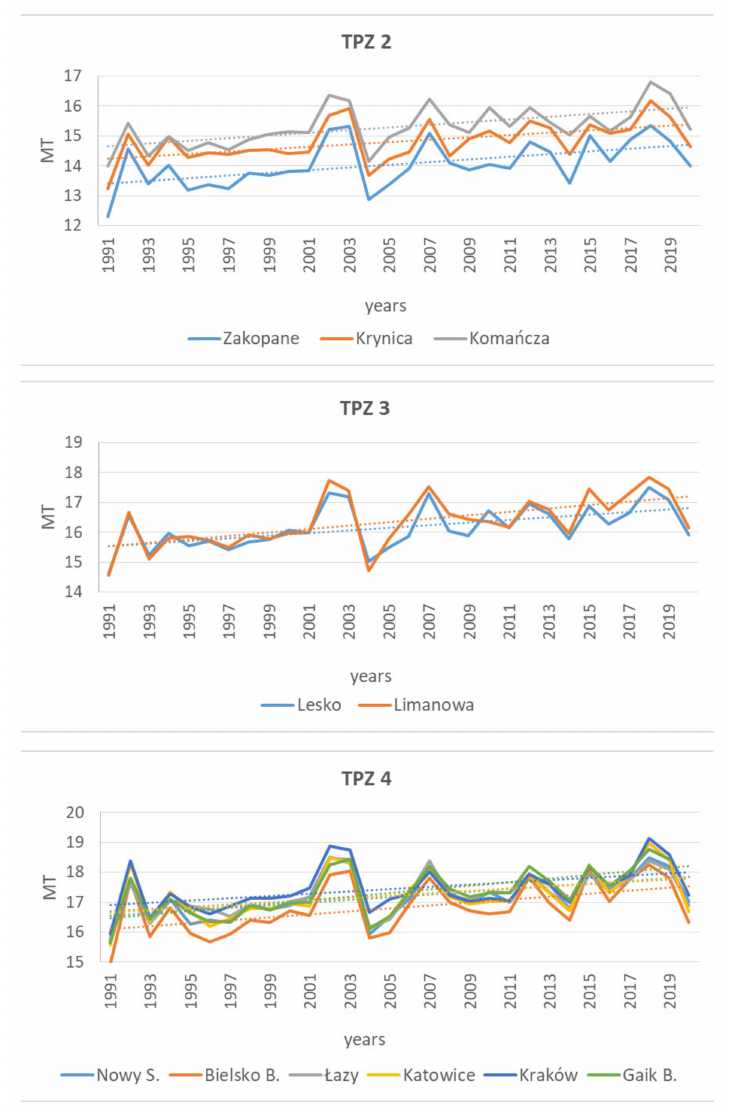
Figure 10. Values of the Mayr Tetratherm Index for particular TPZs and stations in the period 1991–2020, together with linear trends. See Appendix D for regression equations and the values of R 2 . Stations are ordered following the concept of TPZ explained in Section